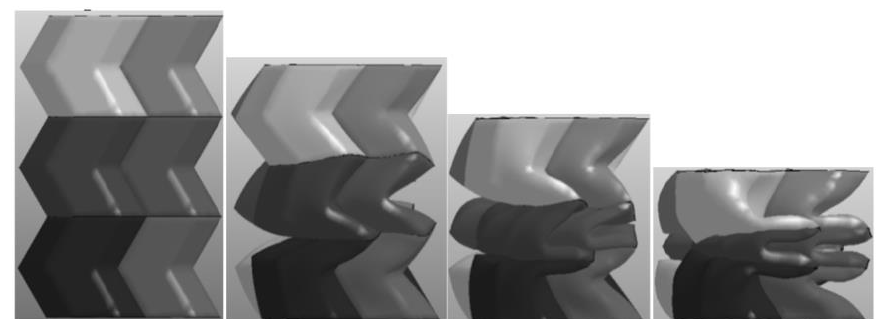
Figure 19. The deformation process under simulation.